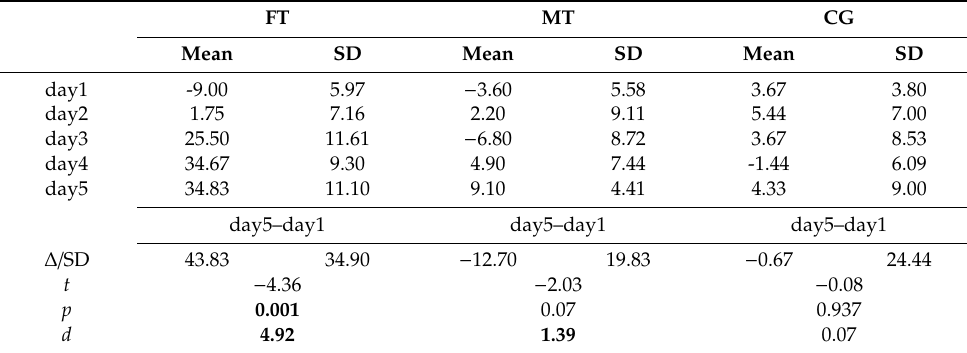
Table A9. Mean values and e ff ect sizes for the prominent Deck B. phenomenon (calculated as Deck D-Deck B) within the training group.